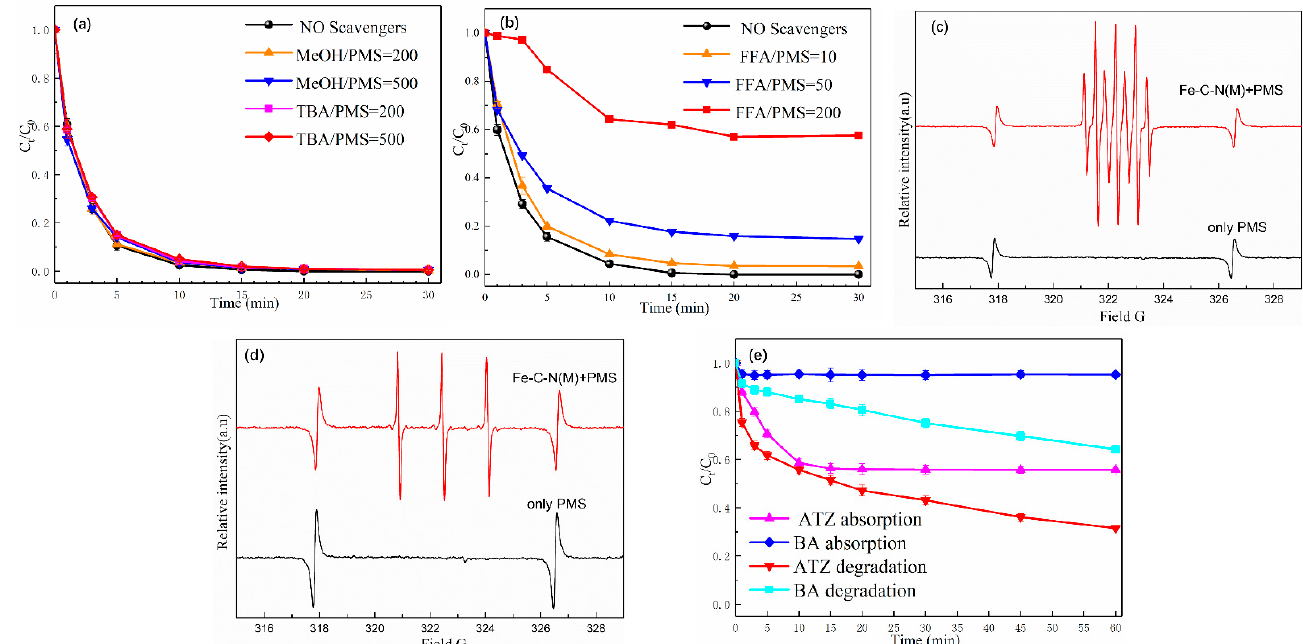
Figure 9. ( a ) Quenching experiment of MeOH and TBA; ( b ) Quenching experiment of FFA; ( c ) DMPO is the EPR diagram of the capturing agent; ( d ) TEMP is the EPR diagram of the capturing agent; ( e ) Probe experiment.